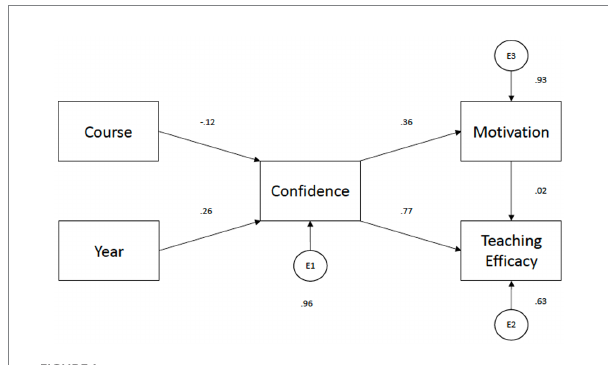
FIGURE 1 Hypothesized path model of relationships between confidence, motivation and teaching efficacy.